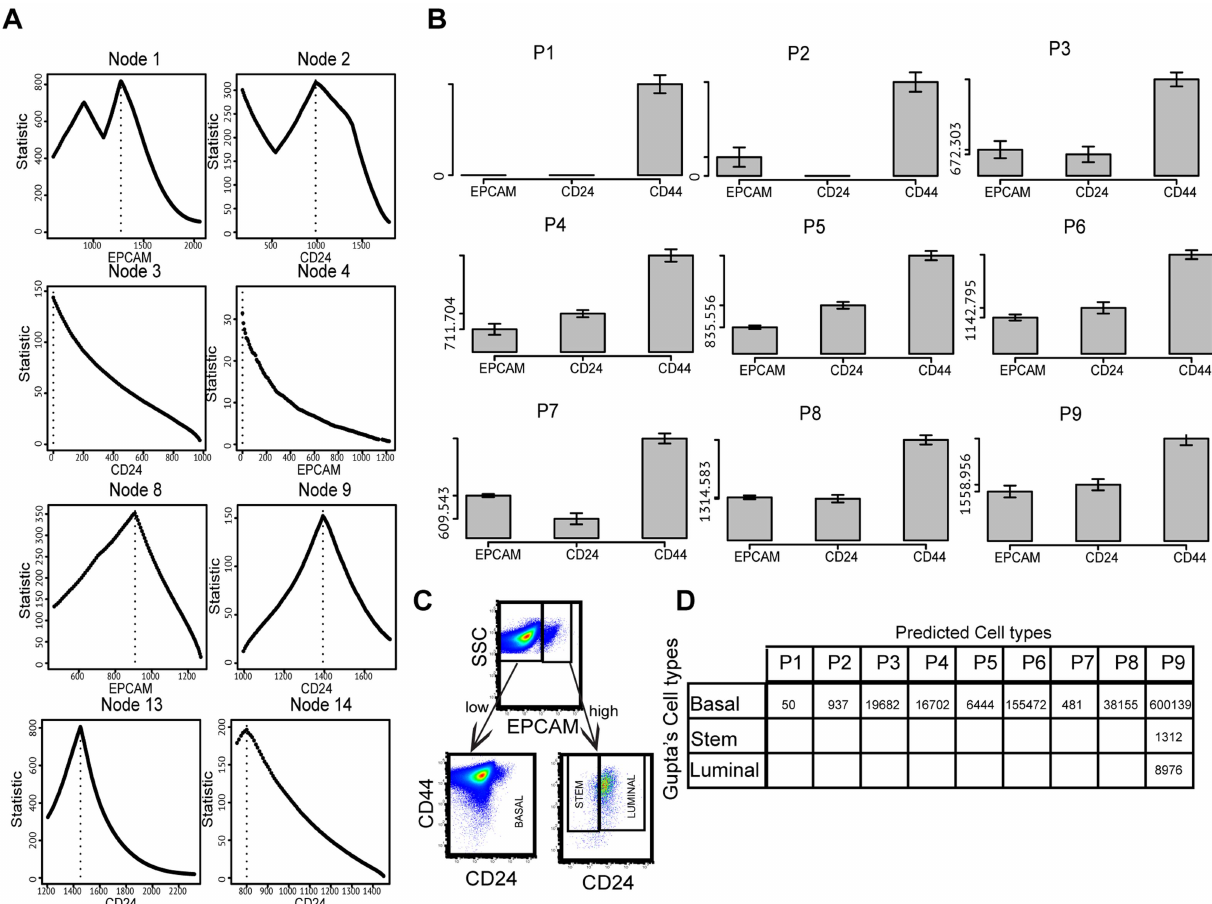
Figure 7. CCAST analysis on SUM159 breast cancer results. A Results for the estimation process for all the split point statistics in all the inner nodes in Figure 6. The root node corresponding to EPCAM shows one local maxima and one global maximum. Gating the data from this global maximum results in 9 distinct subpopulations. Nodes 3, 4, 8, 9, 13 and 14 have clear natural maxima indicating optimal splits for the data into these 9 homogenous subpopulations (see Figure 6) corresponding to the 9 bar plots in B . B Bar plots of the 9 homogenous subpopulations from Figure 6 across all 3 markers with standard deviation intervals for each marker. The values on the bars on the left side of each plot correspond to the minimum value for all 3 bar heights. Each side bar gives a sense of the relative difference between bar heights. The main title for each plot shows the corresponding leaf node bin on the tree in Figure 6. Predicted Celltypes 3 and 1 correspond to P3, P4, P7 and P5, P6, P8 respectively indicating more homogeneous sub populations than expected. The bar plots show evidence of at least 5 distinct sub populations i.e. P1, P2, P5, P7 and P9. C Gupta et al. [3] gating strategy isolated 3 cell states (Basal, stem, and luminal) using EPCAM as the major marker. They further use CD24 to sort out these 3 states. We also automatically identify EPCAM as the major marker but use a combination of multiple splits from CD24 and EPCAM to produce 9 homogeneous bins. D Comparison of predicted breast cancer subpopulations comparing the CCAST versus Gupta et al. [3] gating strategy shows potential evidence of contamination after sorting. This analysis indicated the CCAST subpopulation P9 is clearly a mixture of basal, stem, and luminal subpopulations from Gutpa et al. [3]. Unique CCAST subpopulations P1 and P2 were not even identified by Gupta et al. [3].